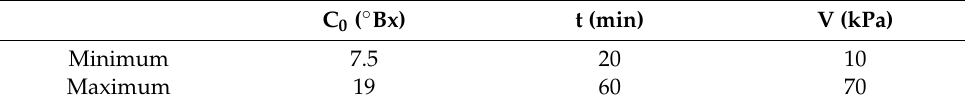
Table 1. Experimental